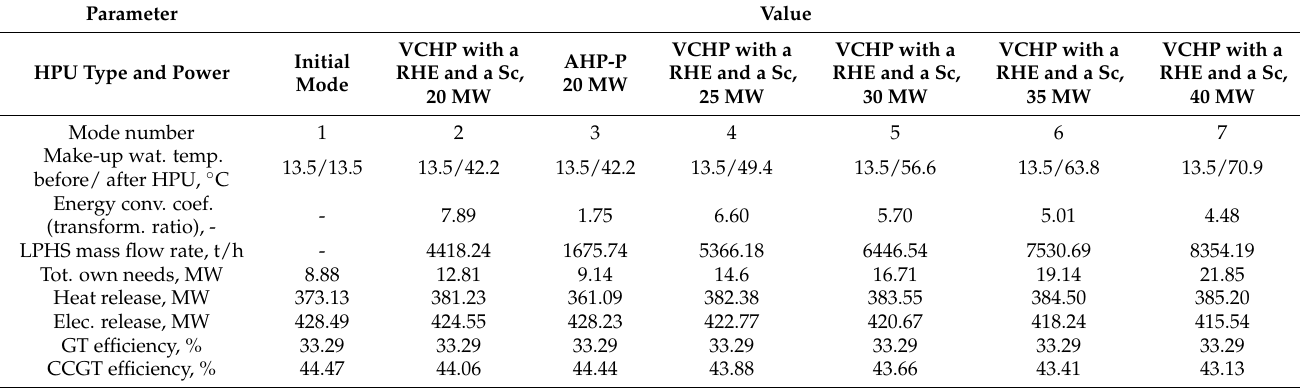
Table 8. Winter modes simulation results of using HPUs for heating make-up water with a flow rate of 1500 t/h.